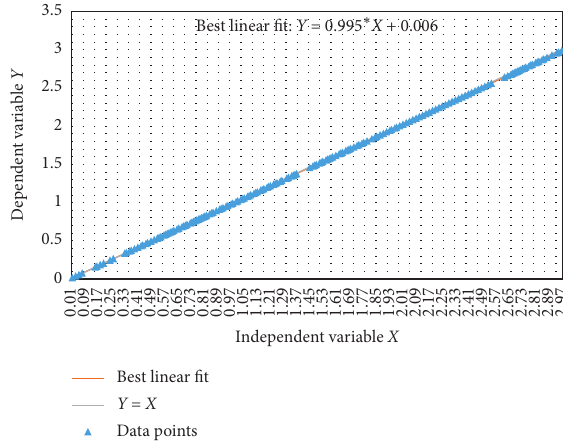
Figure 7: Regression analysis results after optimization. Table 3: Comparison of the mean square error results of the three algorithms on the test function.